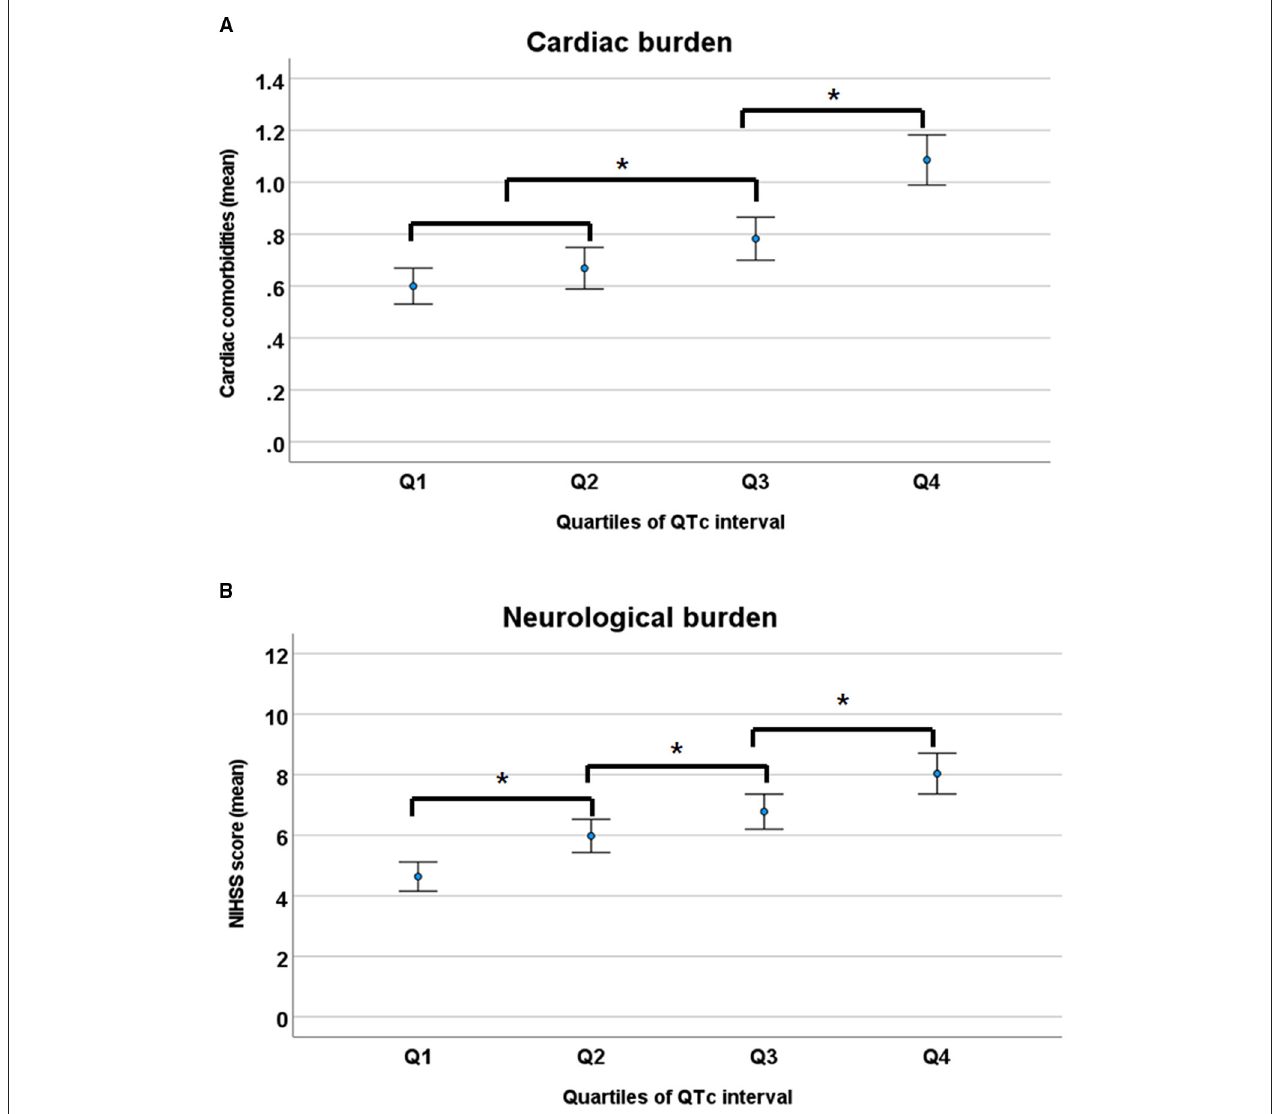
FIGURE 2 | Cardiac (A) and neurological burden (B) according to the quartiles of QTc intervals. NIHSS, National Institutes of Health Stroke Scale. * p < 0.05 by ANOVA with Duncan post-hoc test.